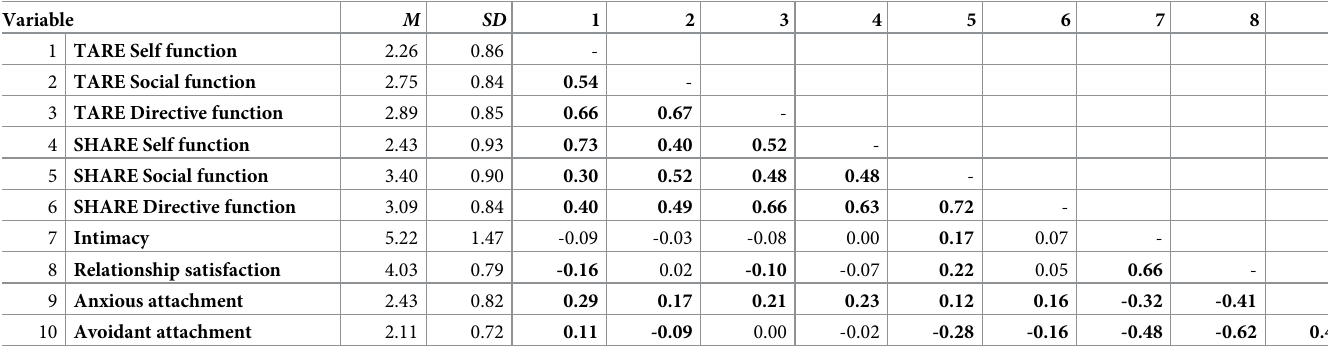
Table 6. Descriptive statistics and correlations among the Study 3 variables.